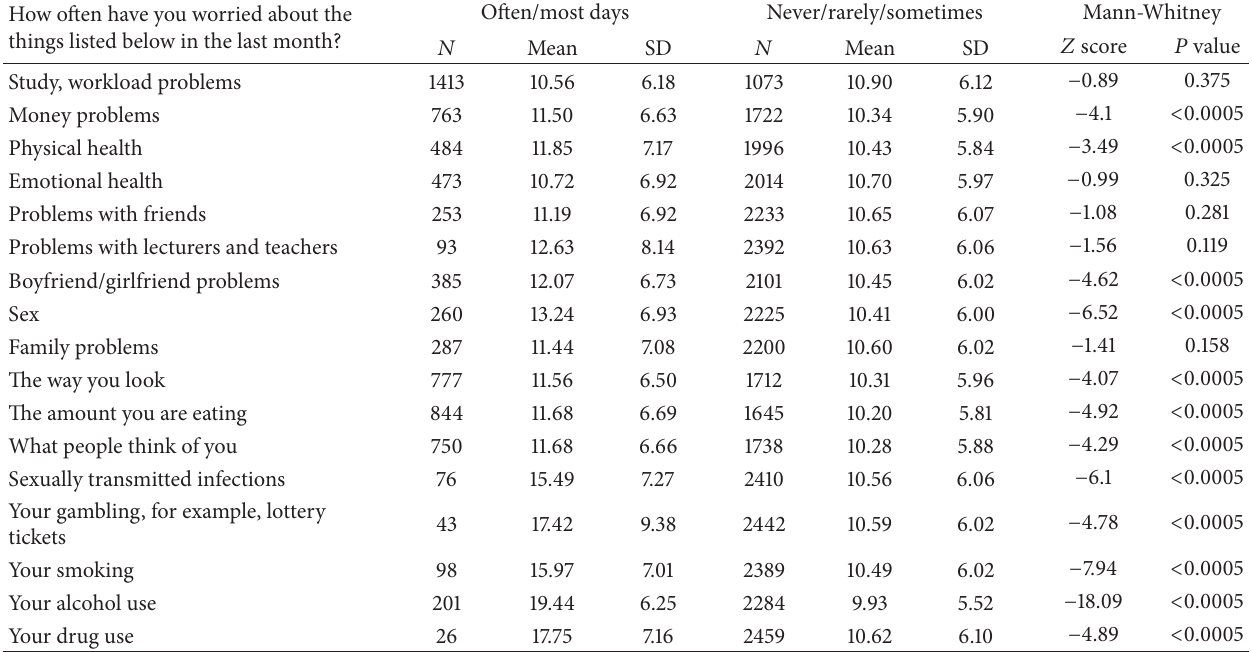
Table 5: Differences in AUDIT score in relation to